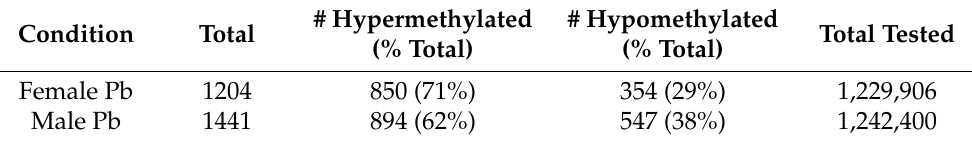
Table 1. Differentially methylated cytosines (DMCs) in 5 month offspring mouse hearts.